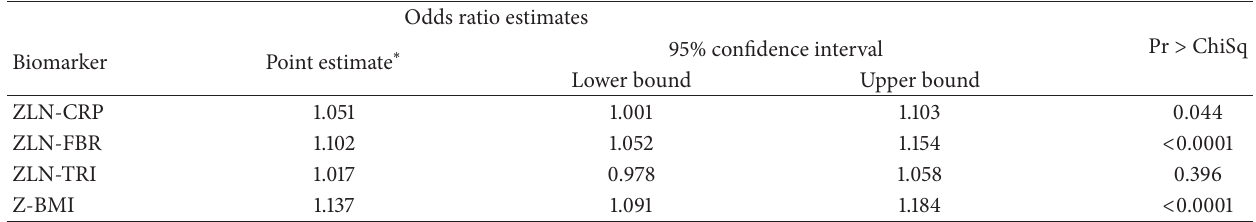
Table 3: Odds ratio of risk factors measures and relationship to chronic pain.